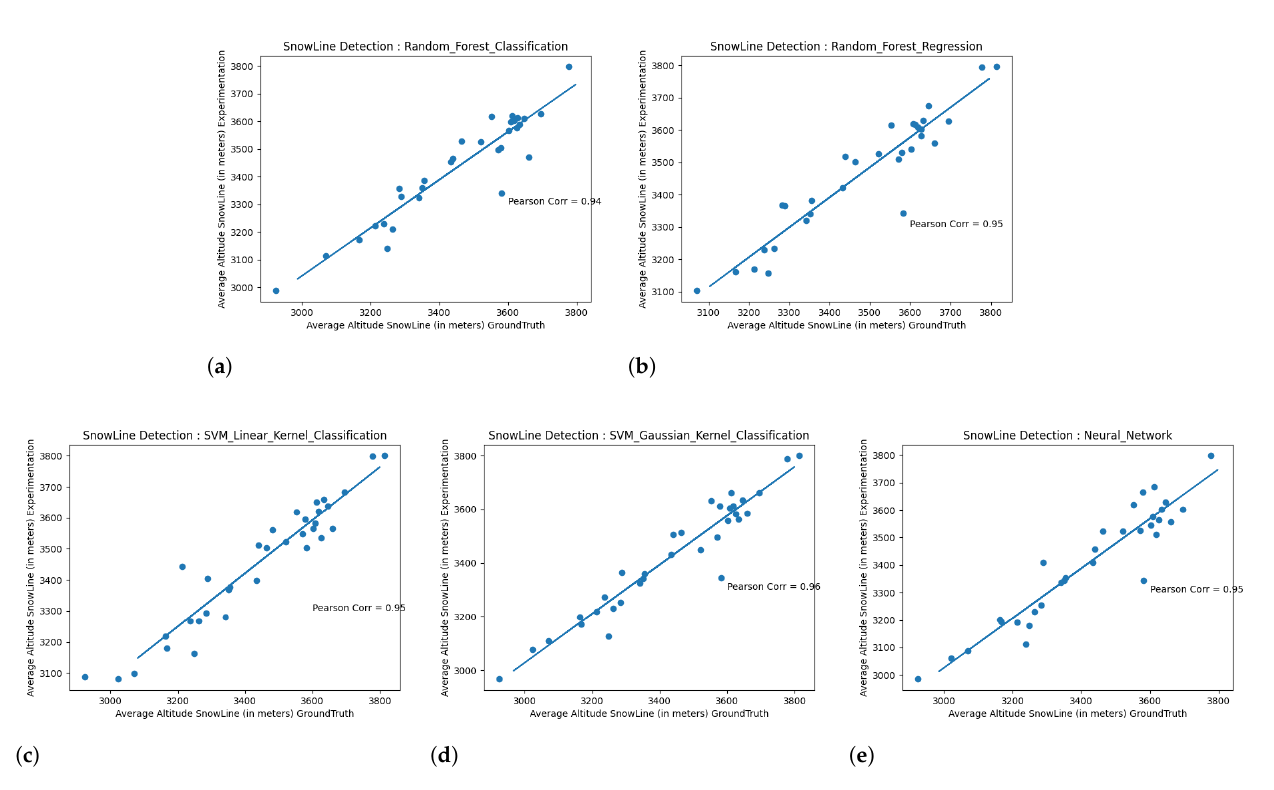
Figure 11. Active contour snow line detection algorithm performance over the ground truth for the 3 September 2019 Landsat 8 scene. ( a ) Ground truth snow line altitude vs. active contour approach with a random forest classification snow mapping SLA. ( b ) Ground truth snow line altitude vs. active contour approach with a random forest regression snow mapping SLA. ( c ) Ground truth snow line altitude vs. active contour approach with a SVM and linear kernel snow mapping SLA. ( d ) Ground truth snow line altitude vs. active contour approach with a SVM and Gaussian kernel snow mapping SLA. ( e ) Ground truth snow line altitude (SLA) vs. active contour approach with a neural network snow mapping